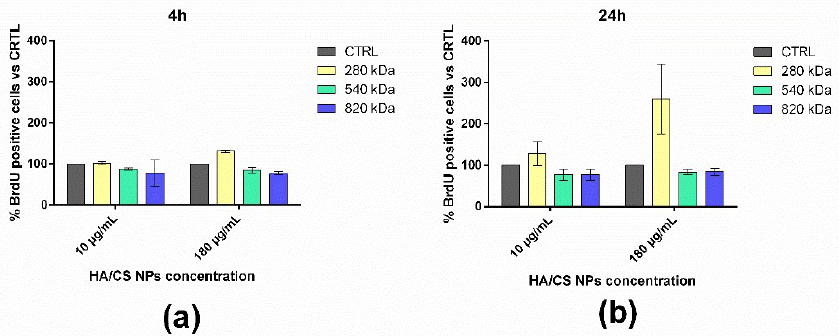
Figure 3. Effect on hMSCs proliferation of HA/CS NPs made of HA with Mw of 280 kDa (yellow bar), 540 kDa (green bar) and 820 kDa (blue bar) after an incubation time of ( a ) 4 h and ( b ) 24 h. CTRL (grey bar) represents untreated cells. Results are expressed as percentage of proliferating cells (BrdU positive nuclei) compared to the total viable cells.